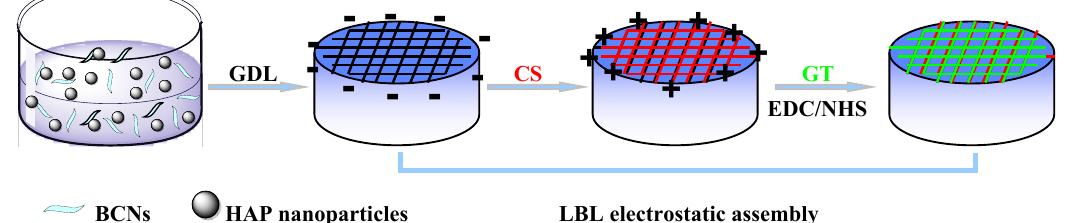
Scheme 1. Schematic diagram of the preparation of Alg/BCNs-CS-GT composite scaffolds through internal gelation and LBL electrostatic assembly.